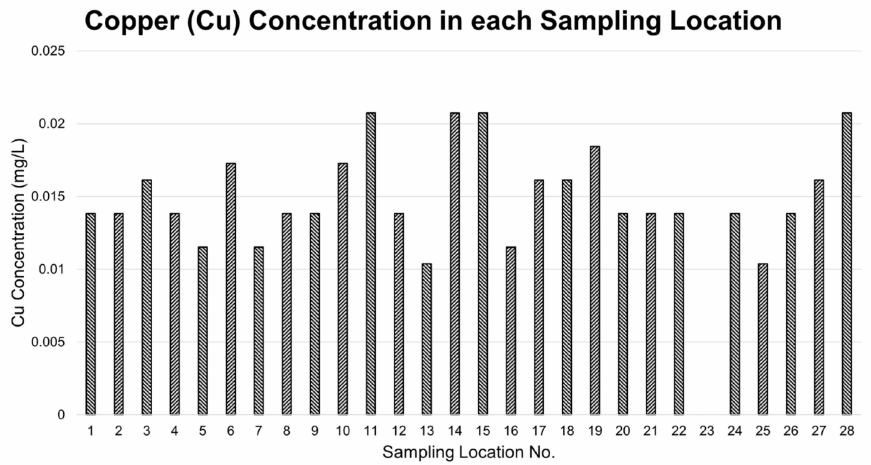
Figure 4. Concentration of Cu in GW